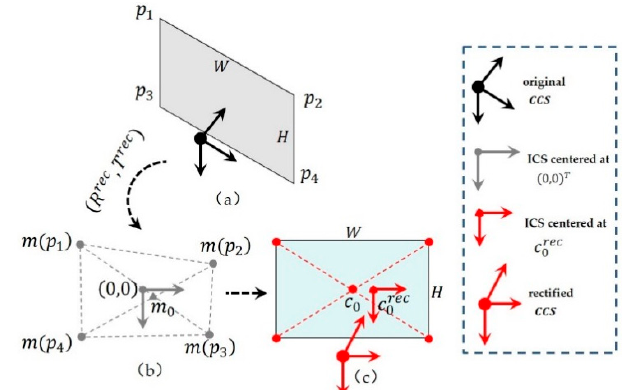
Figure 6. Determination of the imaging center after stereo rectification: ( a ) four vertices of the image plane in original CCS , ( b ) assumed image coordinate system ( ICS ) centered at ( 0,0 ) T , and ( c ) rectified CCS and ICS.